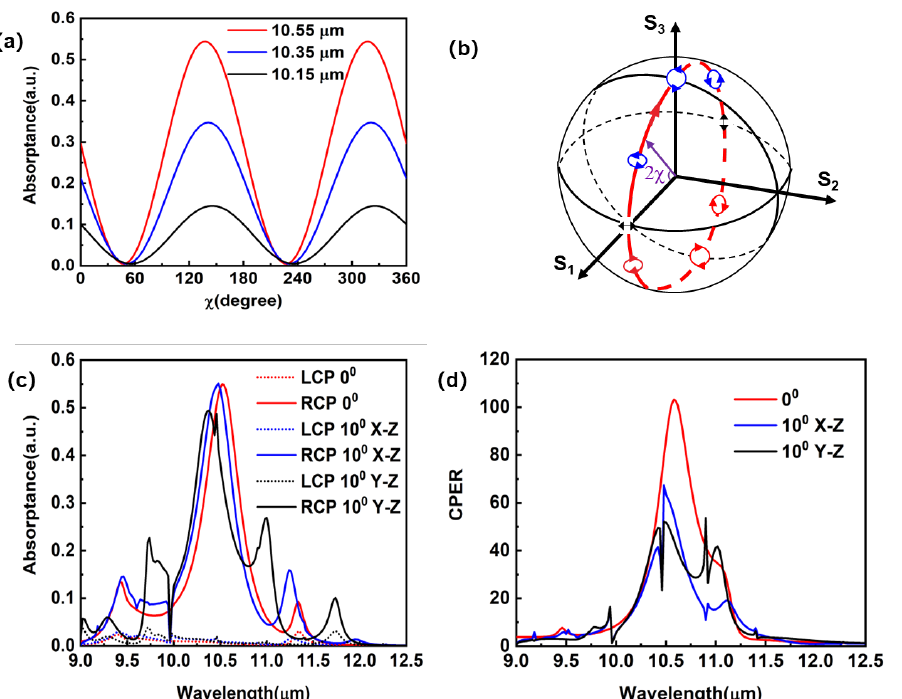
Figure 5. ( a ) Light ellipticity angle dependent absorption efficiency of the dielectric-metal-hybrid chiral metamirror integrated QWIP at different wavelengths. ( b ) Poincare sphere with a longitude circle crossing the S 1 axis. ( c ) Absorption efficiency spectra for LCP and RCP light at an oblique incidence of 10° in the x - z and y - z plane. ( d ) CPER spectra for oblique incidence of 10° in the x - z and y - z plane.